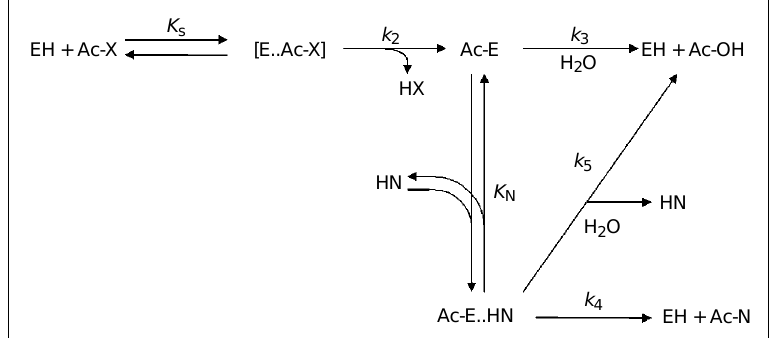
Figure 1 - Kinetic model of a protease-catalyzed acyl transfer reaction. EH, Free enzyme; Ac- X, acyl donor; HX, leaving group; Ac-E, acyl enzyme complex; Ac-OH, hydrolysis product; HN, acyl acceptor; Ac-N, aminolysis